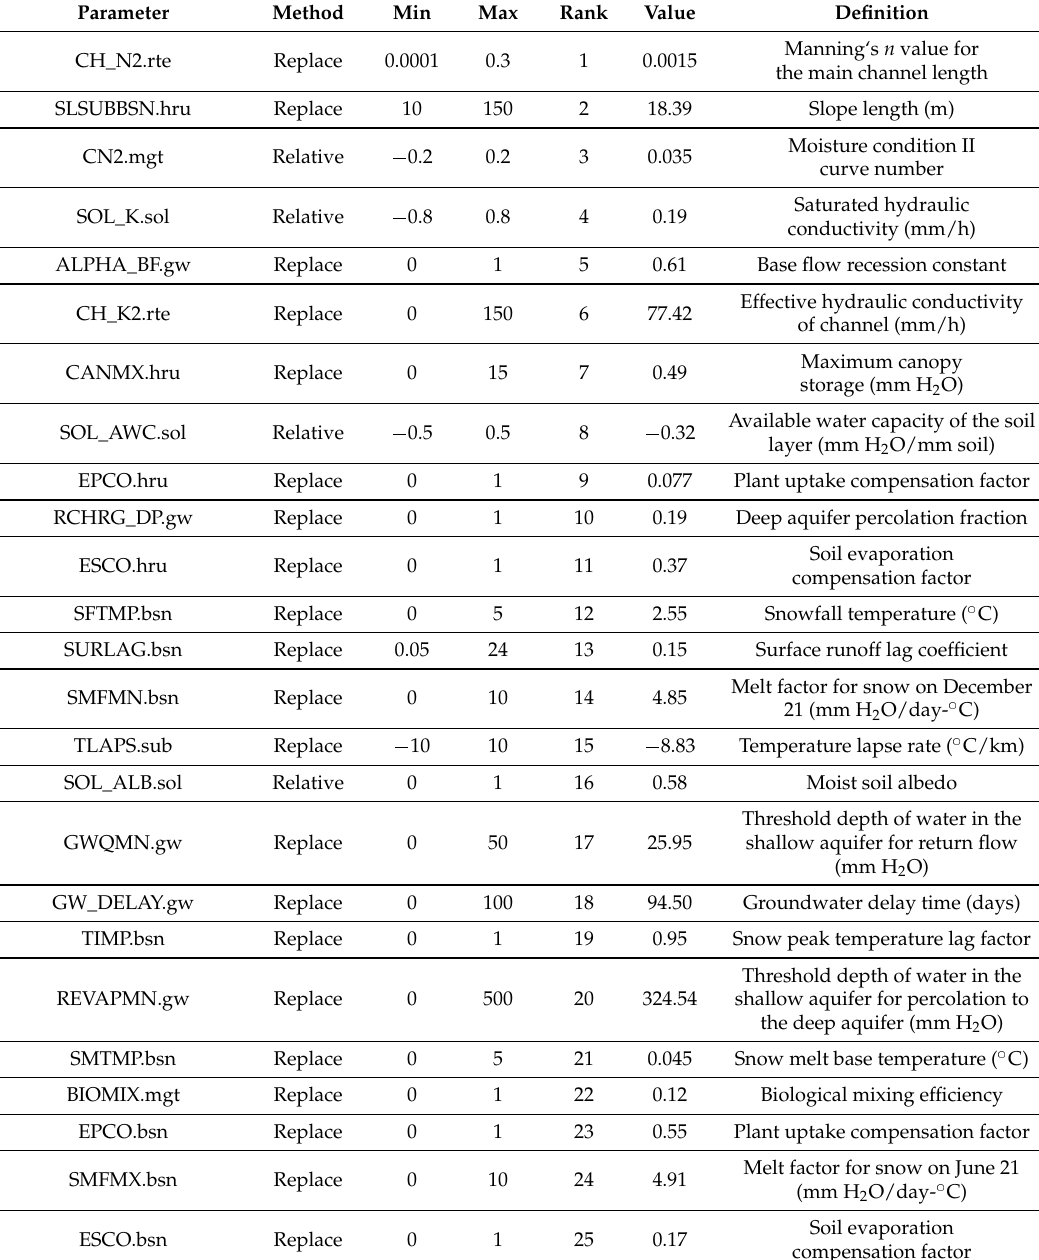
Table 1. SWAT calibration results for 25 hydrologic